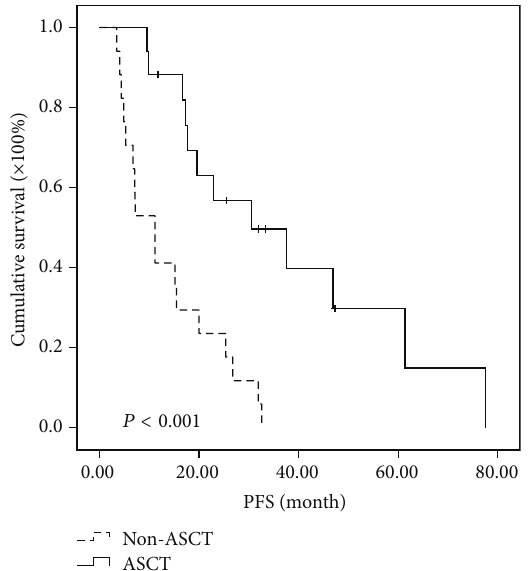
Figure 5: Comparison of PFS in the patients of ASCT group and non-ASCT group in the intermediate-risk subgroup. The median PFS was 25.7 versus 15.1 months with no significant difference ( 𝑃 = 0.05 ).